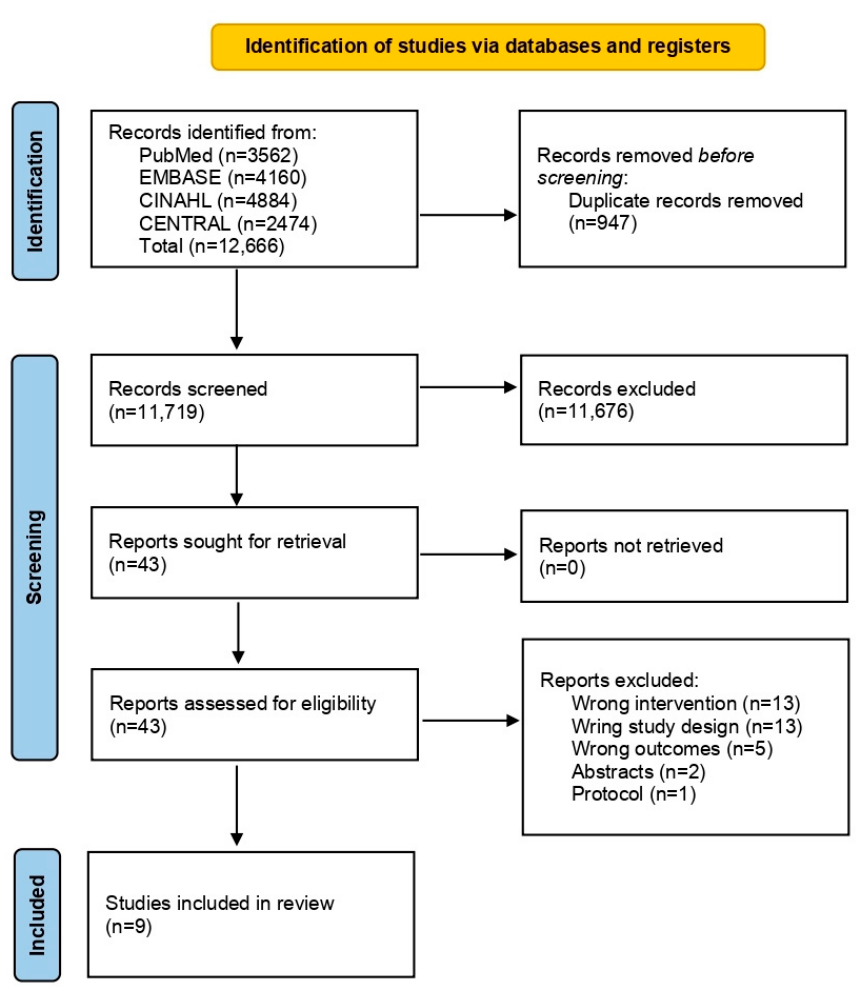
Figure 1. PRISMA flow diagram of literature search, screen and selection criteria.